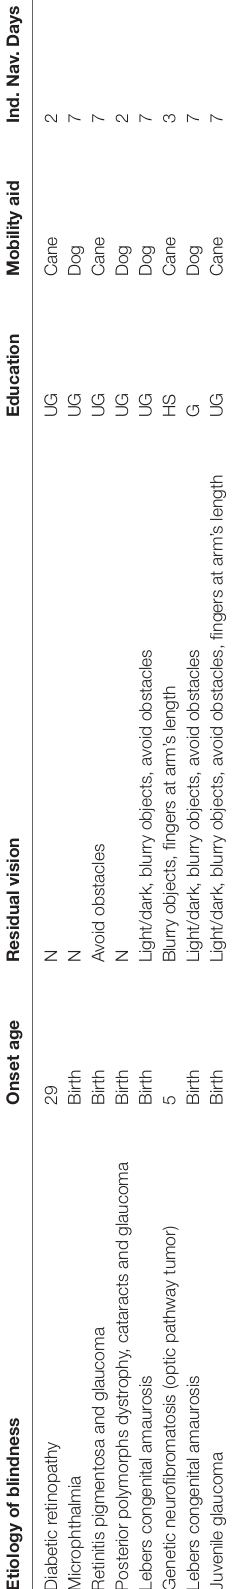
features of the map such as hallway junctions: ‘‘corner,’’ ‘‘three- way,’’ or ‘‘dead-end,’’ or target objects: ‘‘cat.’’ Users could tap on any part of a hallway to hear the total length of the corridor between junctions (in feet). The spoken target labels and home location could also be repeated by tapping on its x-y position on the map. Volume was user selected, and the speech played at a rate of approximately 150 words per minute. The edges of the screen were framed using cardboard (see Figure 3 ) to provide a haptic border and to eliminate accidental contact with any ‘‘soft’’ buttons of the device that could interfere with the map presentation software. Maps were presented via either the VAM interface (DIM) or a HTM that was mounted on the same tablet (HIM), allowing for identical auditory cues between conditions and equivalent logging of finger movement